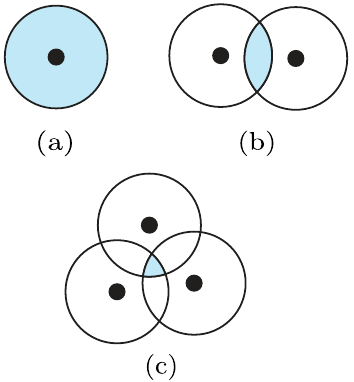
Figure 3. Region of possible solutions for x n as function of the number of proximity